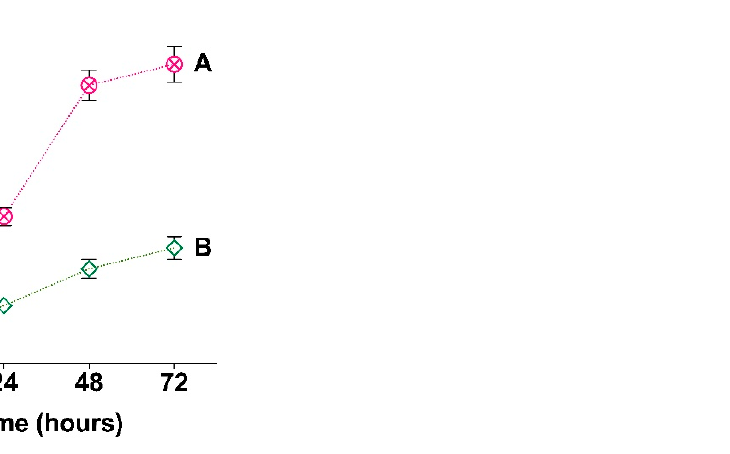
Figure 14. Results of fluorescence analysis of attached DAPI-labeled MSCs on the surface of: ( A ) 3D printed matrix PLA-MA/NCC-MA + 20% GelMA and ( B ) cryogelated matrix PLA-MA/NCC-MA + 20% PEGDA after 6, 24, 48, and 72 h after seeding.